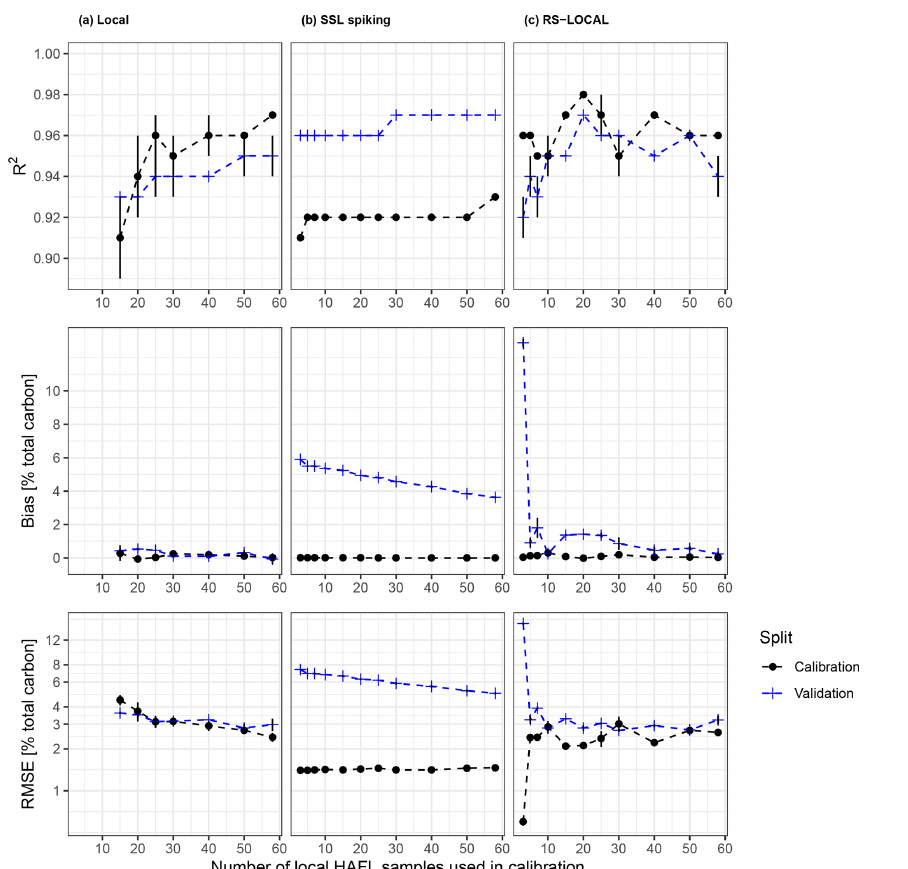
Figure 7. R 2 , bias and RMSE values in percent of total carbon (RMSE in logarithmic scale) vs. the number of local HAFL samples used in local HAFL (a) , local combined with SSL (b) and RS-LOCAL subsets (c) , where k = 100. Error bars represent the SD between resampled repetitions, and where not present, there was no variation in the respective summary statistic across five repetitions. Dashed lines between data points do not represent real measurements and are only for visual